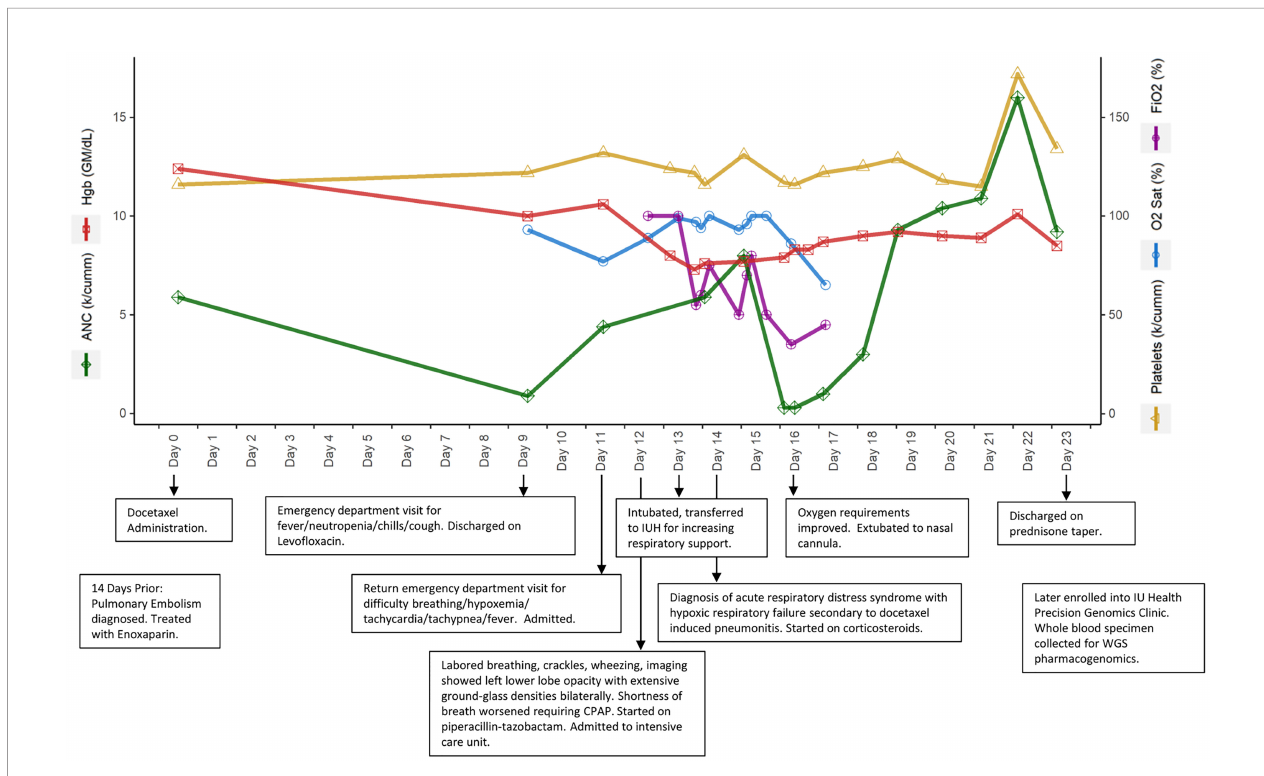
FIGURE 1 | Timeline of events and select lab values for patient